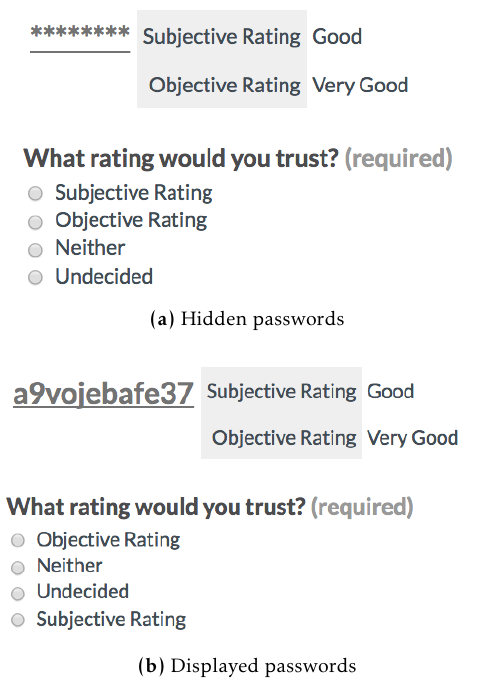
Figure 1. Screenshots of hidden and displayed password questions and rating options. Table 1. Six passwords used in our experiments and their strength ratings, shown in 5-point scale (Very Weak,